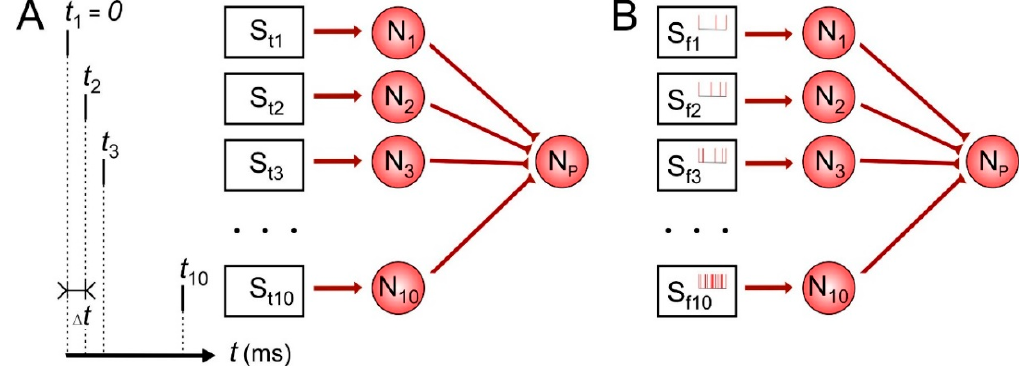
Figure 1. Temporal ( A ) and rate ( B ) coding scheme for single neuron. S t1–t10 , S f1–f10 —stimulators with temporal and frequency rate parameters correspondently, N 1–10 —presynaptic neurons, Np—postsynaptic neuron, t j —stimulating pulse time for neuron N j . ∆ t = t j + 1 − t j —time between pulses.